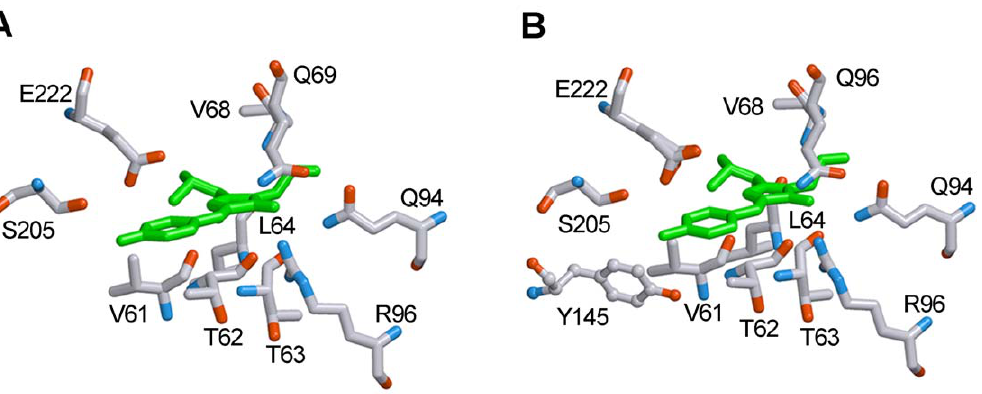
Figure 8. The structure of chromophore environment of sfGFP ( A ) and EGFP ( B ). The localizations of residues involved in chromophore environment are shown. Tyr145 near the chromophore of EGFP ( B ), which is absent in the environment of sfGFP ( A ), is drawn in a distinct manner. Carbon, nitrogen and oxygen are gray, blue and red, respectively. The figure is created on the basis of PDB data [38] with the files 2B3P.ent for sfGFP [35] and 2Y0G.ent for EGFP [39], using the graphical software VMD [69] and Raster 3D [70].